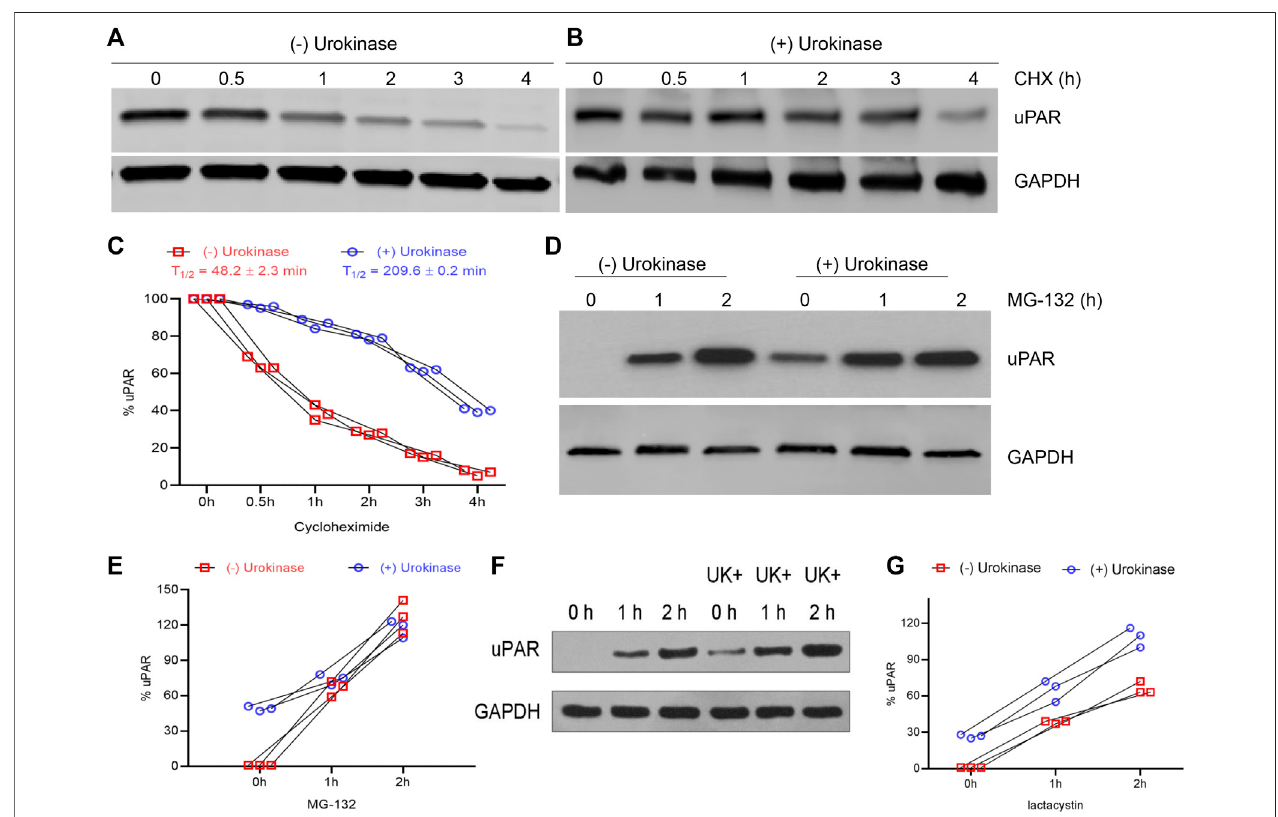
FIGURE 3 | H/R induces degradation of uPAR protein, which can be inhibited using UK. (A – C) BEAS-2B cells subjected to H/R ± UK were treated with 10 μ g/ml cycloheximide for indicated times and lysates were probed with anti-uPAR and GAPDH antibodies. Shown are representative blots (A,B) and quanti fi cation of protein half-life (C) . (D,E) Same as (A,B) but treated with 20 μ M of the proteasome inhibitor MG-132 (D) and quanti fi cation of protein half-life (E) . (F,G) Same as (A) and (B) but treated with 20 μ M of the proteasome inhibitor lactacystin (F) and quanti fi cation of protein half-life (G) (UK: urokinase).